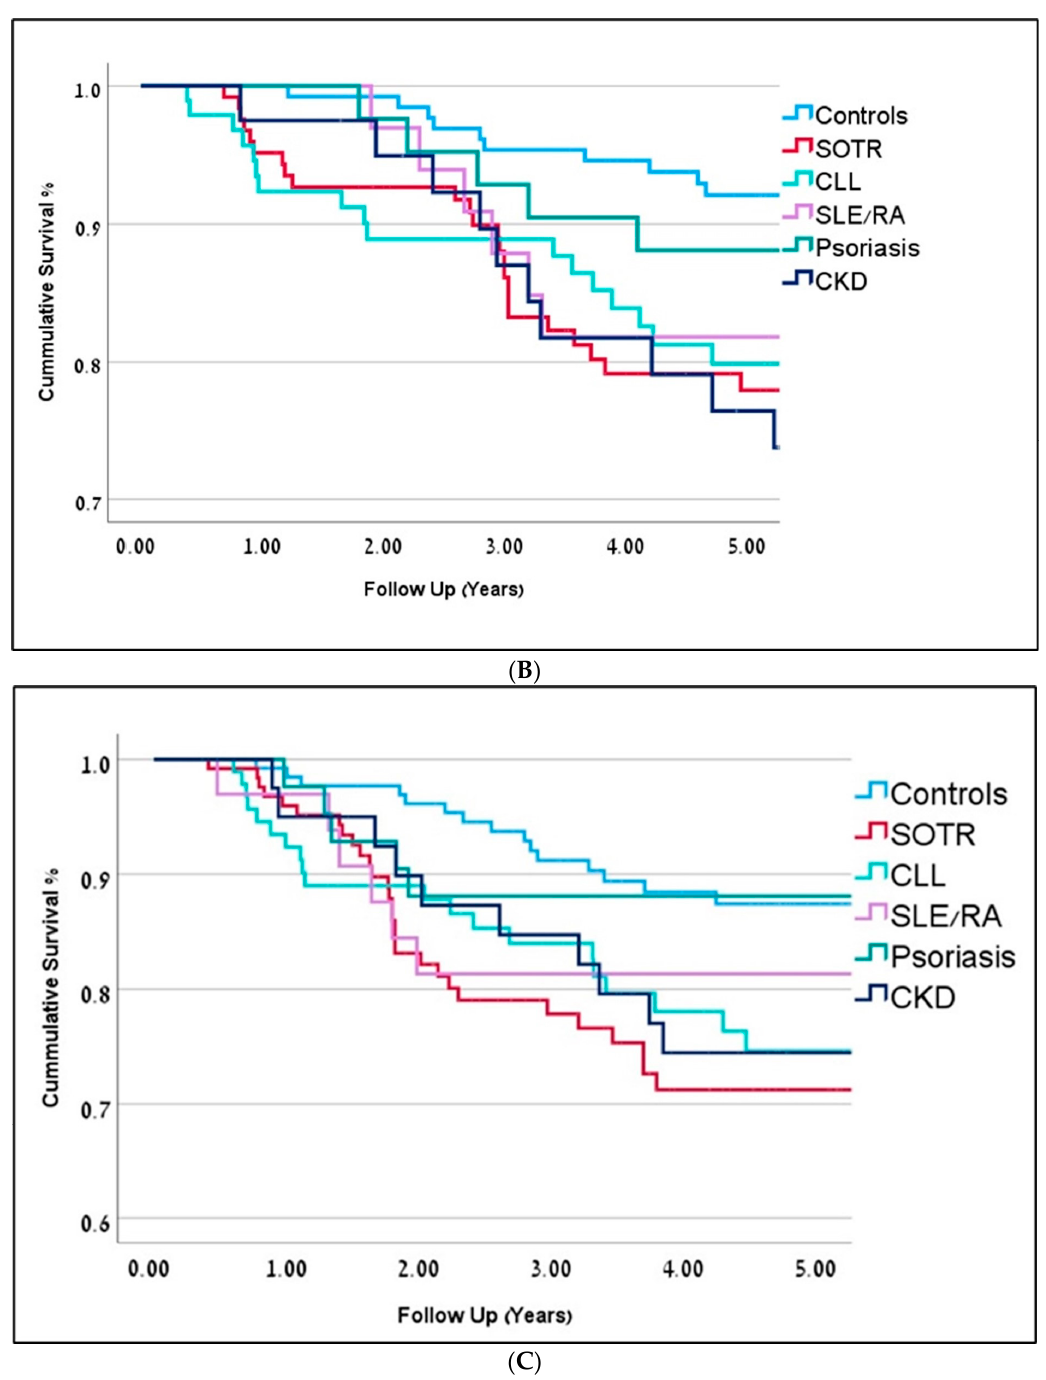
Figure 1. ( A ). Kaplan-Meier curves representing 5-year overall survival for immunosuppressed patients are in dark red (OR-0.81) and controls are in blue (OR = 0.91). Follow-up is represented in years ( p = 0.001). ( B ). Kaplan-Meier curves representing 5-year overall survival (in years) for the different immunosuppression groups. Solid Organ Transplant Recipients (SOTR) in red; Chronic Lymphocytic Leukemia (CLL) in bright green; Chronic Kidney Disease (CKD) in dark blue; Rheumatic Arthritis (RA) and Systemic Lupus Erythematosus (SLE) in purple; Psoriasis in green; Controls in blue. ( C ). Kaplan-Meier curves representing 5-year disease-free survival (in years) for the different immunosuppression groups. Solid Organ Transplant Recipients (SOTR) in red; Chronic Lymphocytic Leukemia (CLL) in bright green; Chronic Kidney Disease (CKD) in dark blue; Rheumatic Arthritis (RA) and Systemic Lupus Erythematosus (SLE) in purple; Psoriasis in green; Controls in blue.